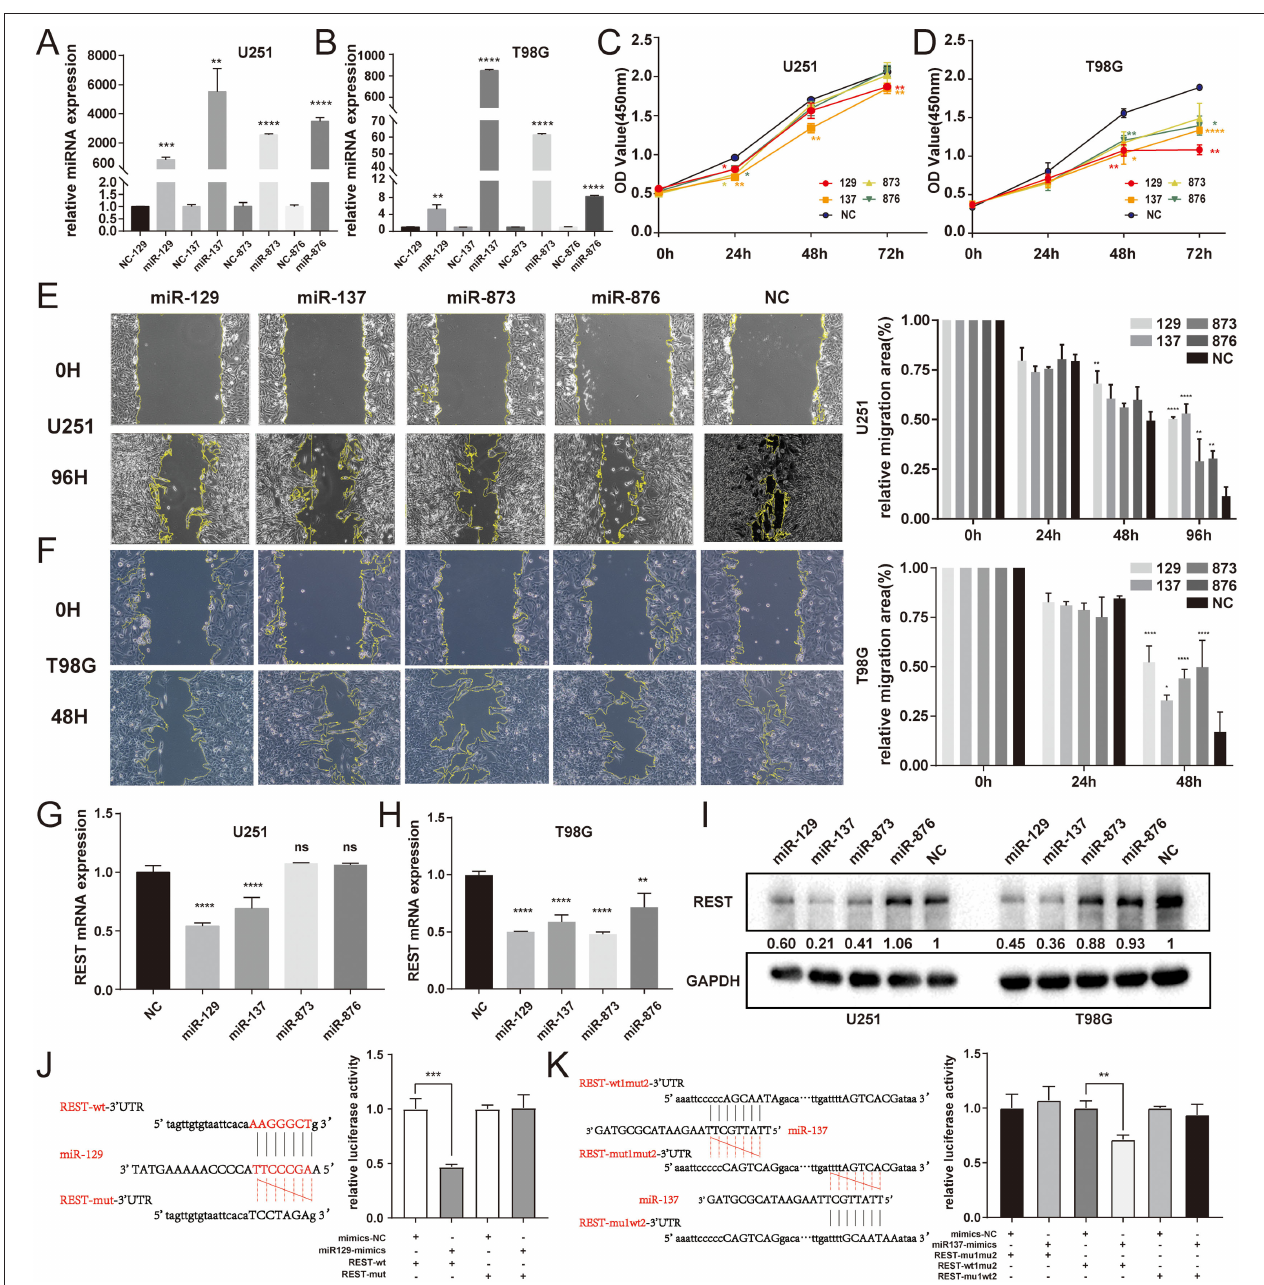
FIGURE 7 | Experimental validation between REST and miRNAs of ceRNA. (A,B) The transfected expression of 4 miRNA-mimics in U251 and T98G cell lines. (C,D) Cell proliferation was determined by CCK8 assay. (E,F) Cell migration was determined by wound-healing assay. The expression levels of REST mRNA (G,H) and protein (I) were determined by qRT-PCR and Western Blot. (J,K) The binding site of miRNA and the 3 ′ UTR of REST were predicted by Starbase and validated by luciferase assay. All data are shown as mean ± SD, * P < 0.05, ** P < 0.01, *** P < 0.001, and **** P <